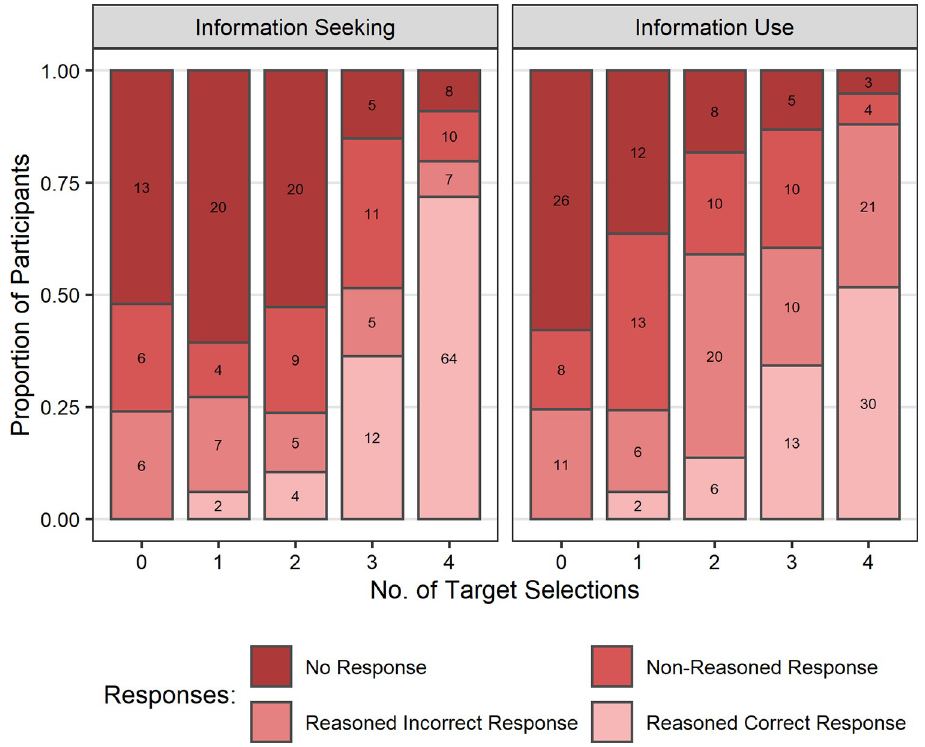
Fig 7. Proportion of participants providing each category of explicit verbal reasoning responses by task performance and reasoning question. Information Seeking: Responses by target video selections; Information Use: Responses by target key selection, target key selections were only possible after a target video selection. Values presented on bars refer to the number of participants each proportion represents.